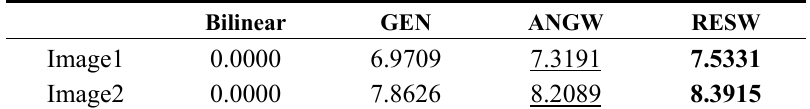
Table 2. ISNR comparisons of the reconstruction results in the simulation image data experiment.